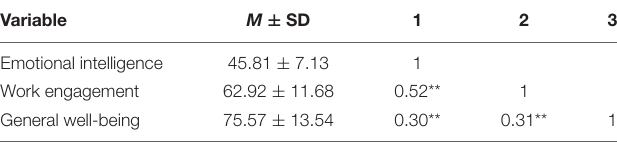
TABLE 2 | Variables descriptive and correlative statistics. TABLE 3 | Confirmatory factor analysis of each